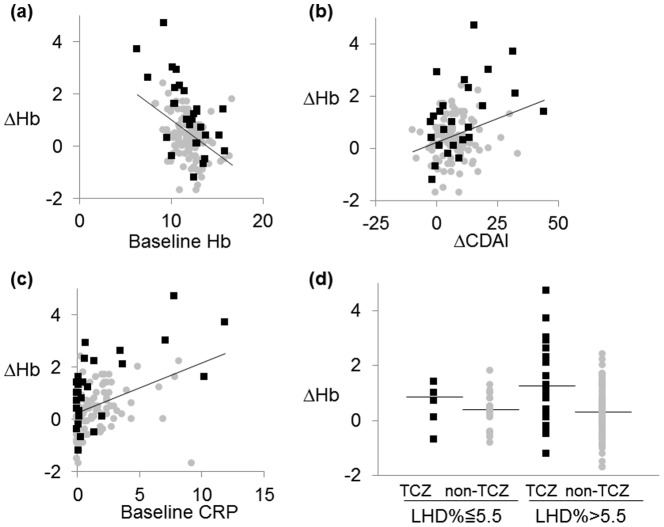
Correlation between the increase of hemoglobin levels and baseline hemoglobin (a), CRP (b), reduction in the clinical disease activity index (c), and baseline LHD% (d).Dot plot suggests the correlation between (a) baseline hemoglobin (Hb) and ΔHb (N = 147), (b) baseline CRP and ΔHb (N = 147), and (c) reduction in the clinical disease activity index (ΔCDAI) and ΔHb (N = 122) in rheumatoid arthritis patients treated by TCZ (black closed square) or non-TCZ biologics (gray closed circle). The straight line corresponds to the best-fit linear regression line for all samples. (d) ΔHb levels in patients treated with TCZ (black closed square) or non-TCZ biologics (gray closed circle) are expressed in two groups divided by the baseline LHD% value 5.5. The straight lines represent the median levels of ΔHb for indicated groups. (ΔHb  =  Hb at week 12 - Hb at baseline, ΔCDAI  =  CDAI at baseline – CDAI at week 12; LHD% =  low hemoglobin density.)